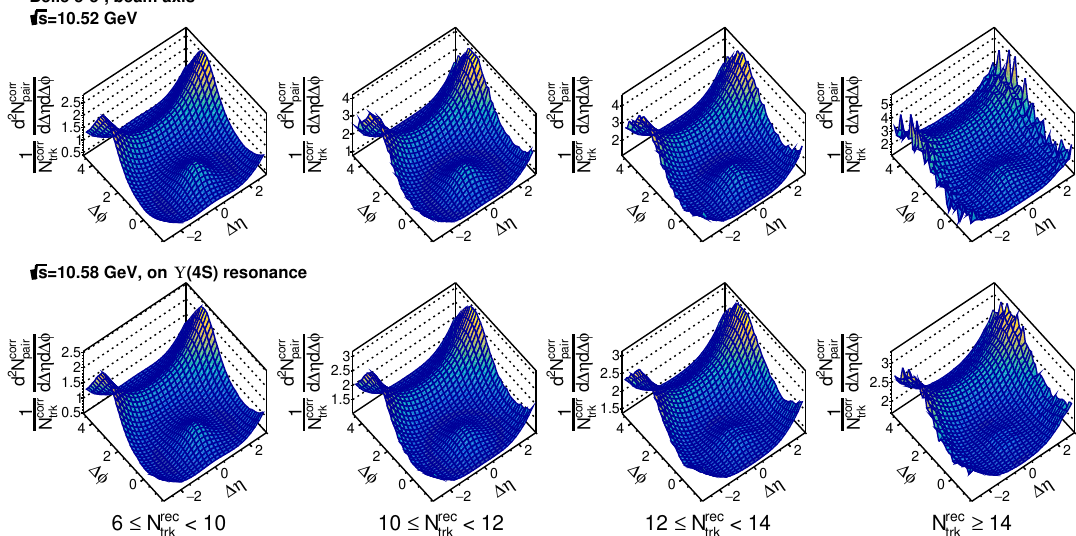
Figure 3. Beam-axis two-particle correlation functions for the off-resonance (top) and on-resonance (bottom) data versus the reconstructed-track multiplicity N rec intervals from left to